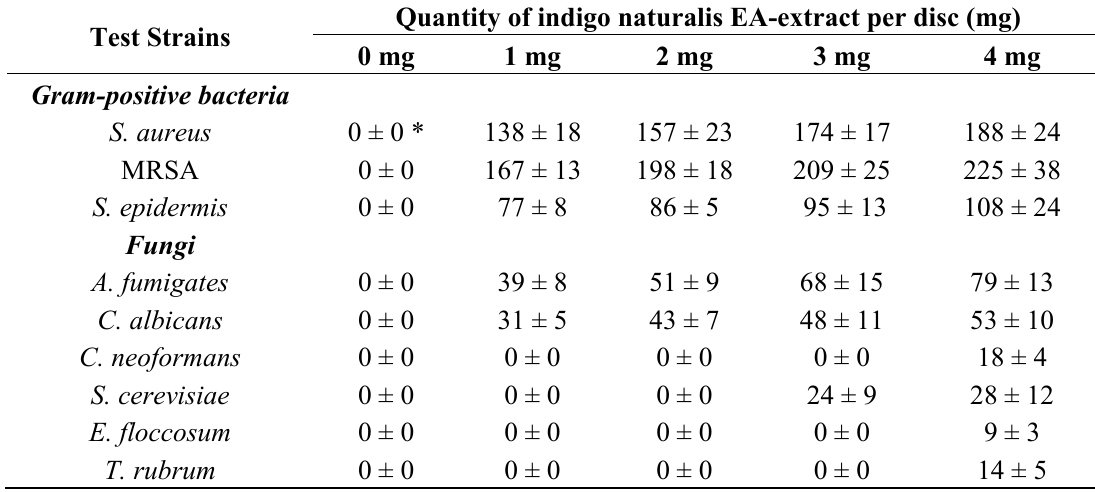
Table 2. The antimicrobial effects of indigo naturalis EA-extract on tested microorganisms. Only the strains sensitive to the indigo naturalis EA-extract are shown. Quantity of indigo naturalis EA-extract per disc (mg) Test Strains Gram-positive